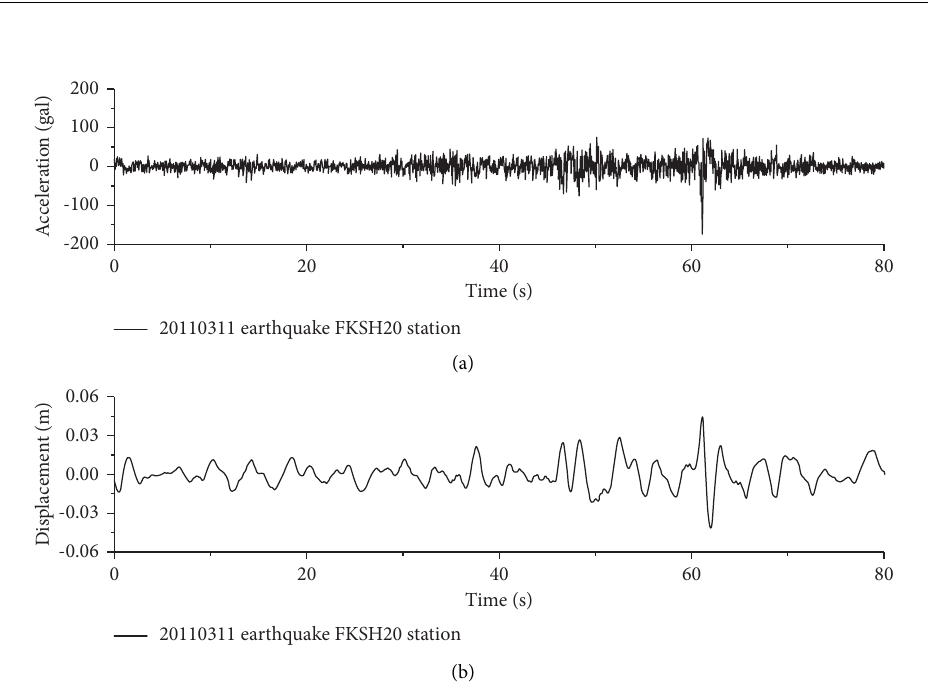
Figure 6: 2011-03-11 Earthquake time history curve at bedrock in the direction of EW-1 at FKSH20 station. (a) Acceleration time history. (b) Displacement time history.